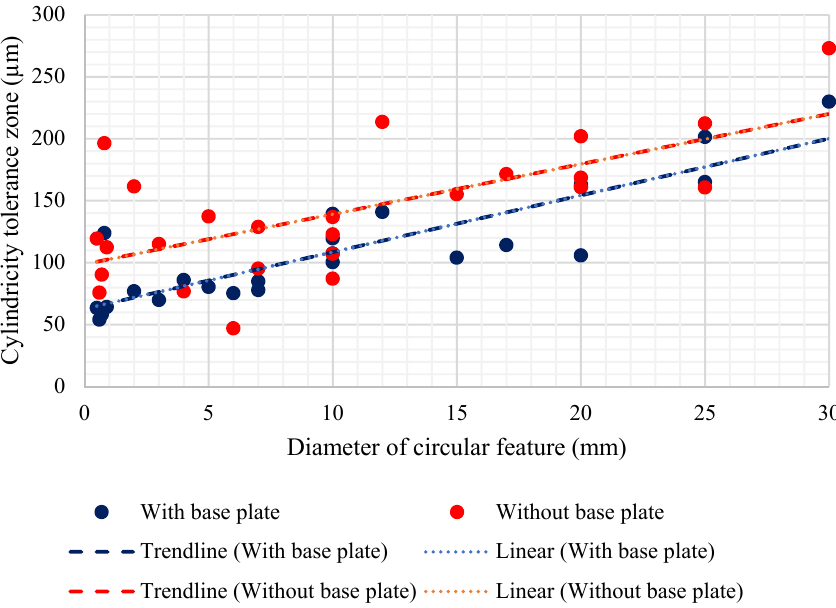
Figure 12. Diameter vs. cylindricity (experimental).